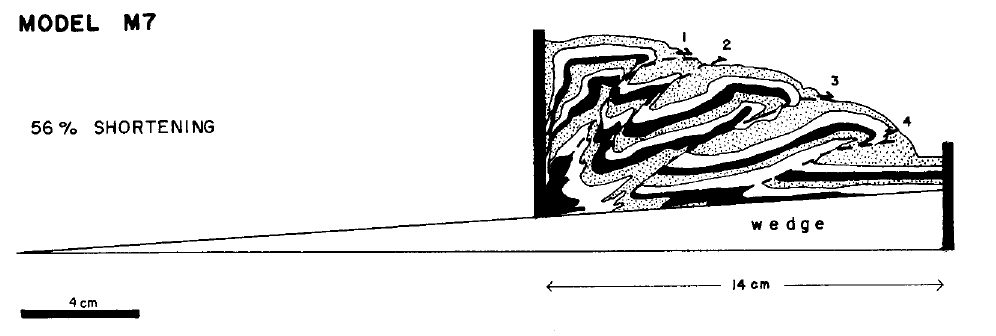
Fig. 17 – Model M7 with a high basal friction and a 5 ◦ inclined basal wedge in the foreland, after 56% shortening. This model shows a similar antiformal stack as in model